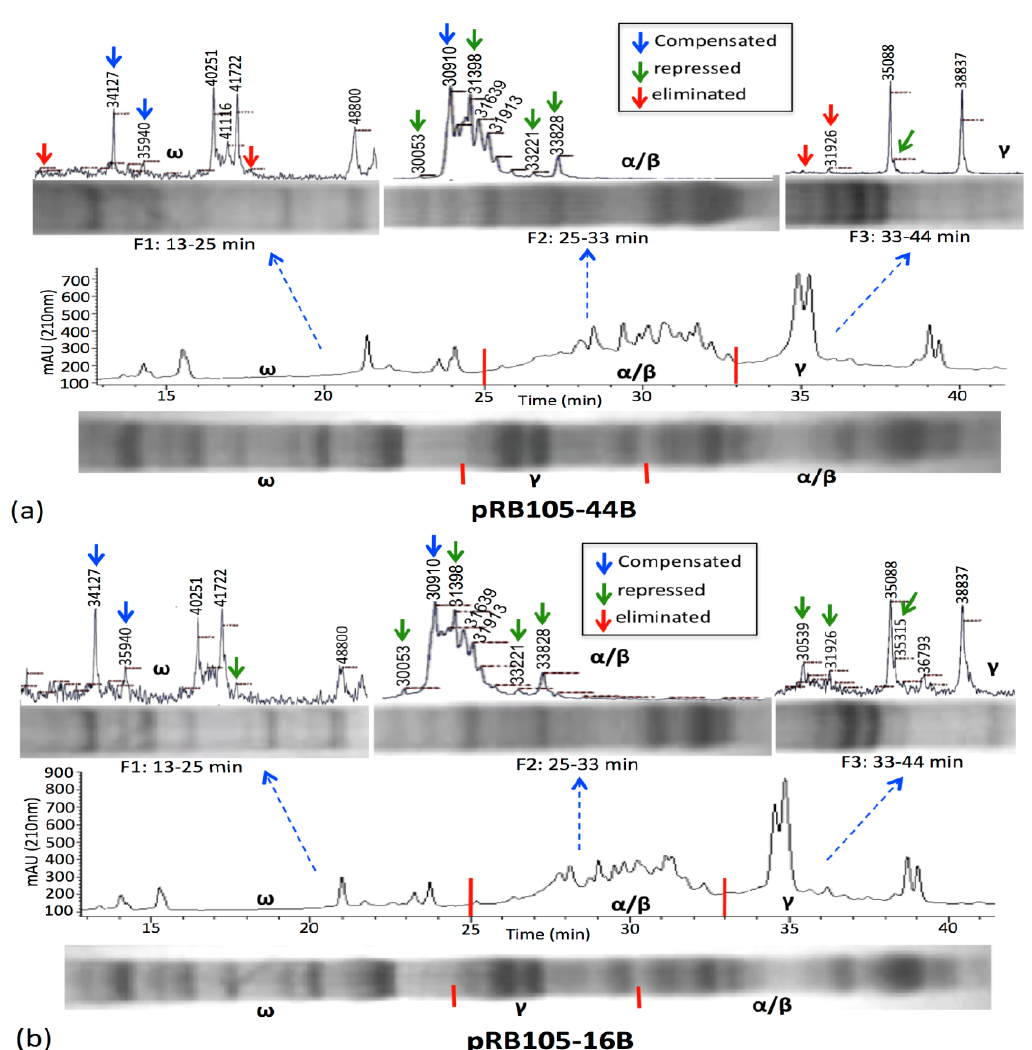
Figure 3. Mass spectra and electrophoresis patterns of gliadin extracts from two wheat transformants, namely pRB105-44B ( a ) and pRB105-16B ( b ). Three HPLC fractions were collected at 13–25, 25–33 and 33–44 min, and resolved on acid-PAGE as well as through MALDI-TOF-MS. Red arrows indicate complete elimination, green arrows